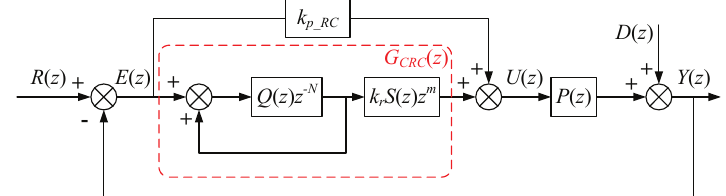
Figure 1. Plug-in CRC control system.